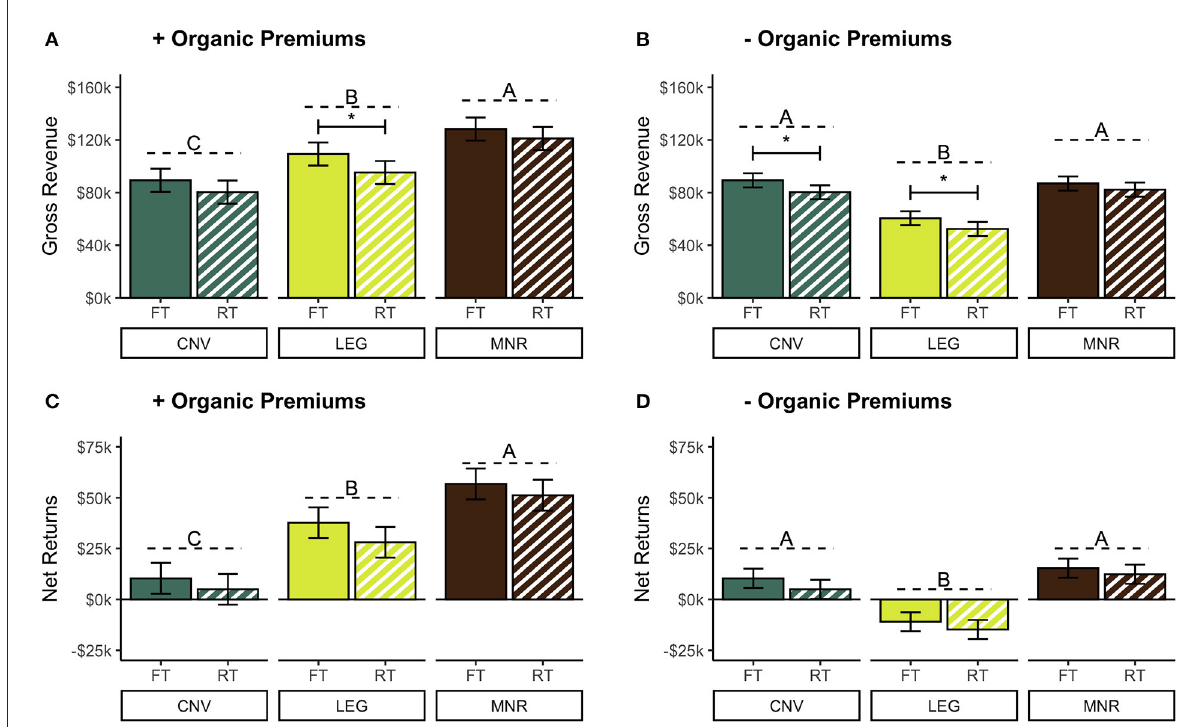
FIGURE3 Average annual gross revenue and net returns for each representative farm with different tillage × system treatments (from 2008 to 2013, 2016 to 2020). Gross revenue (A) with and (B) without organic premiums, net returns (gross revenue – total costs) (C) with and (D) without organic premiums. Error bars are standard errors, different letters indicate significant differences across systems (Tukey HSD, P < 0.05), while asterisks indicate significant differences between tillage treatments within each system (at P < 0.05).